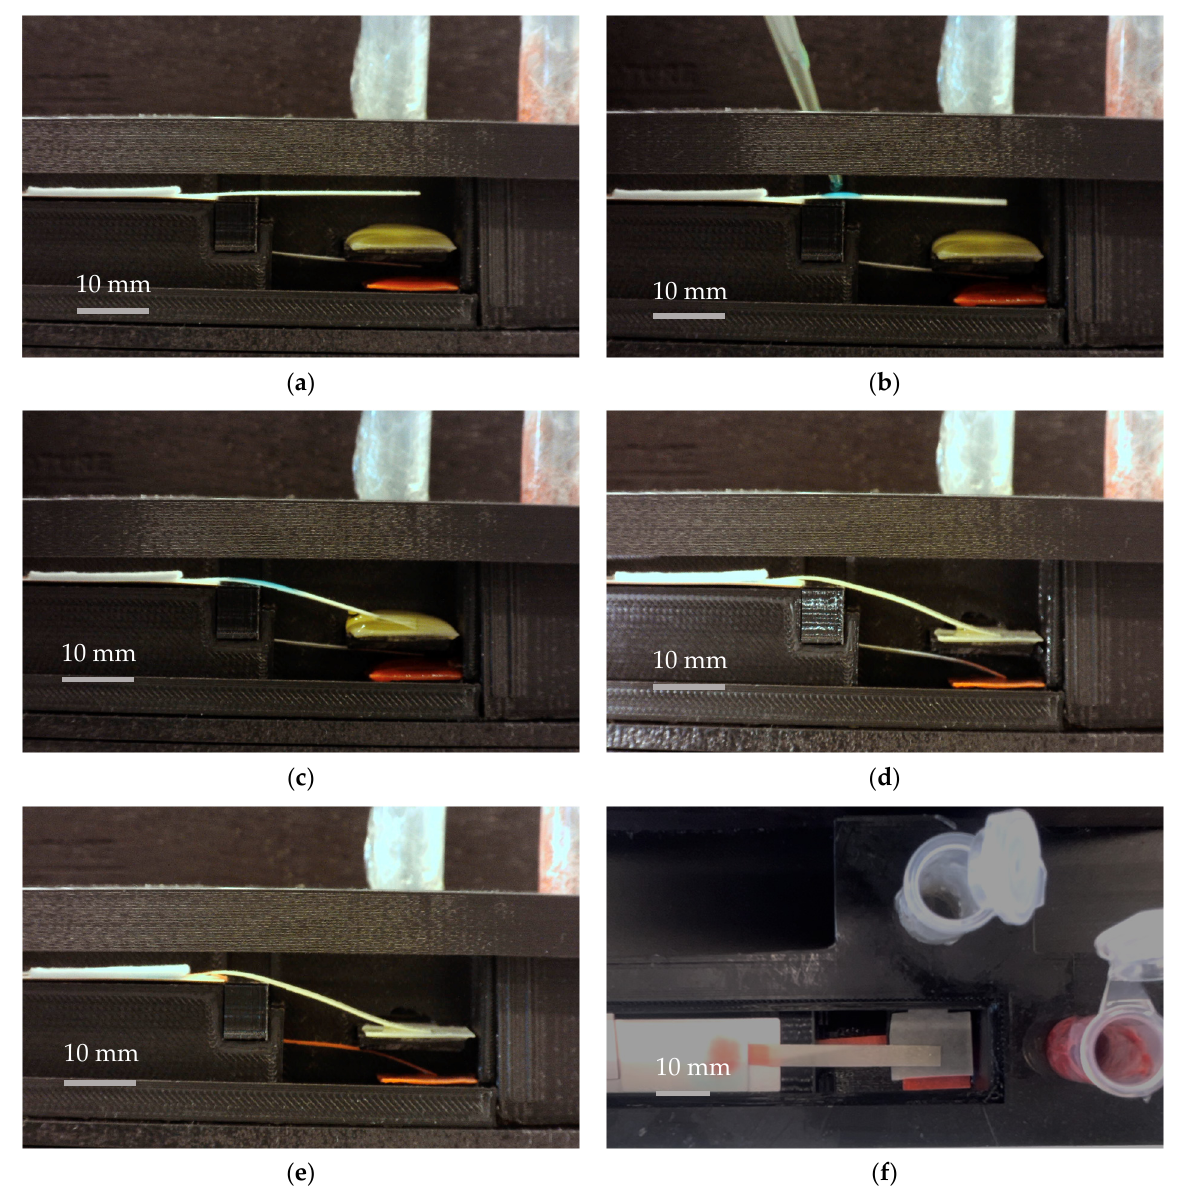
Figure 8. ( a ): Dual B-MaC assembly and positions with respect to the reagent pads (pre-saturated with food color reagents). ( b ): Sample fluid was introduced onto the top cantilever, initiating the loading of yellow reagent. ( c ): Yellow reagent delivered the sample to the conjugate pad and activated the bottom cantilever for the second reagent loading. ( d ): Initiation of the loading of the red reagent towards the detection zone. ( e ): The final results when all of the red reagent is transferred towards the waste pad after passing though the detection zone. The average time ( n = 5) for each step is ( a ) t = 0, ( b ) t = 1 (s), ( c ) t = 4 ± 0.4 (s), ( d ) t = 260 ± 34 (s) and ( e ) t = 610 ± 81 (s). Subfigure ( f ) shows the top view of the device with the final results.